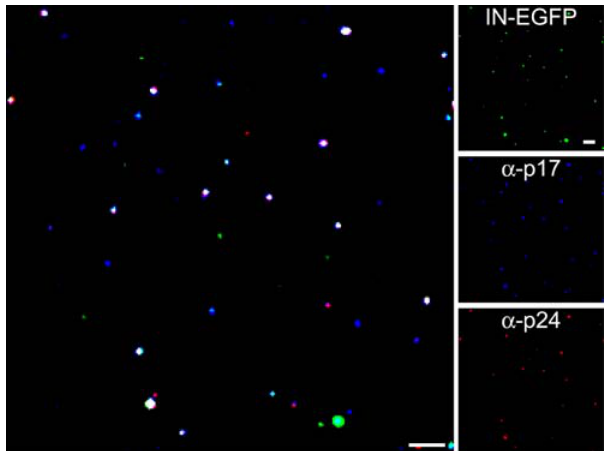
Figure 2. Visualization of HIV-IN-EGFP virions. Supernatants from cells transfected with the pD64E, pVpr-IN-EGFP and pVSV-G plasmids were ultra-centrifuged through a 20% sucrose cushion and adhered to glass coverslips. Following rinsing and fixation, immunostaining was performed with specific antibodies against viral proteins p17 MA and p24 CA and then visualized for EGFP fluorescence (green), p17 MA (blue) and p24 CA (red). Left panel is the merged image where white spots result from overlapping green, blue and red signals. Right panels show the individual fluorescent images. Bars, 5 m m.